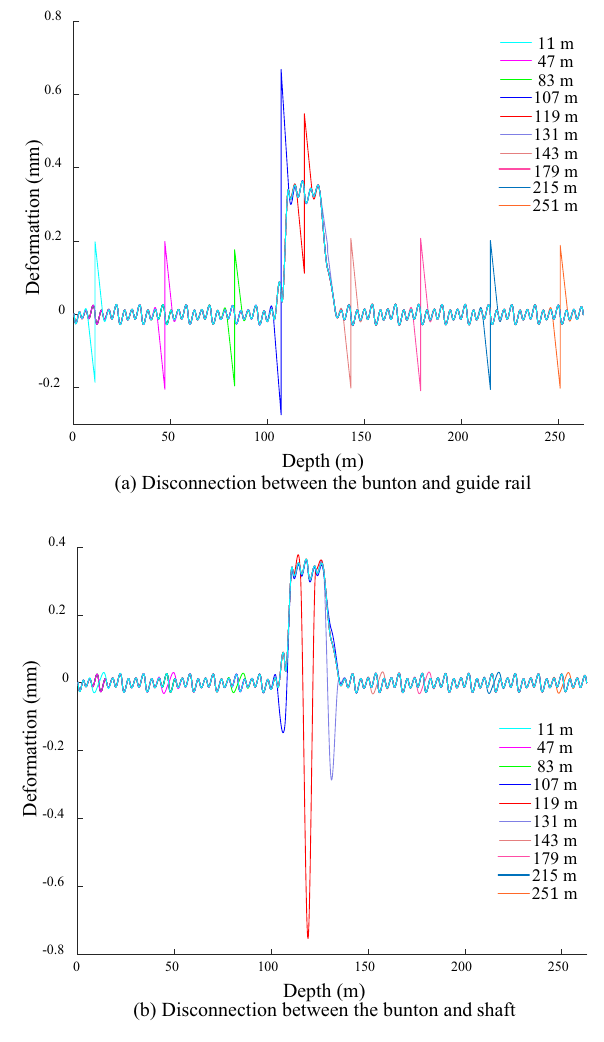
Figure 18. GRD in x -direction under horizontal section change when connection is